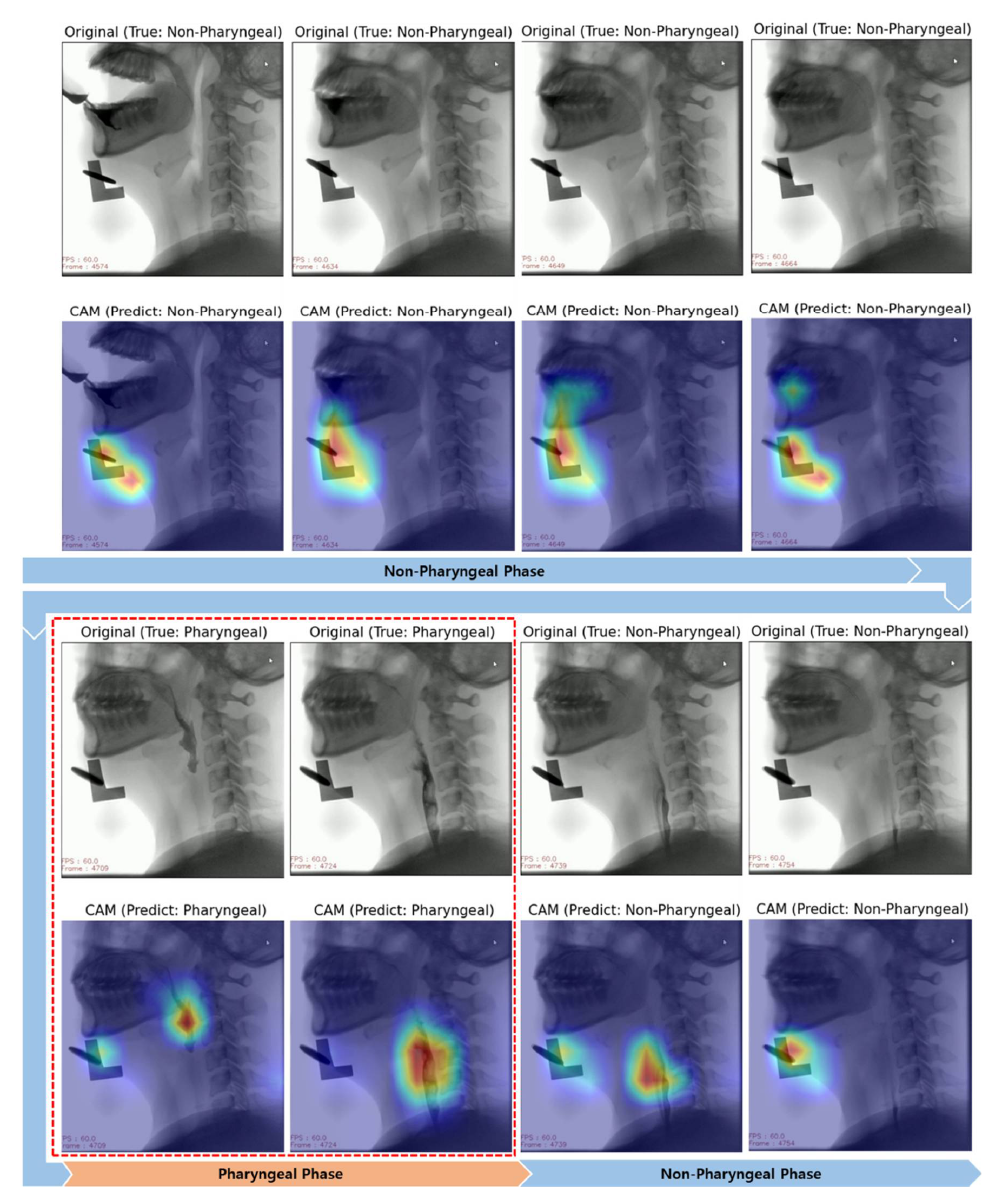
Figure 9. Sample frame images of original and gradient-weighted class activation mapping (Grad-CAM) correctly predicted by the best performing classification model (VGG16-FT5) in this study.